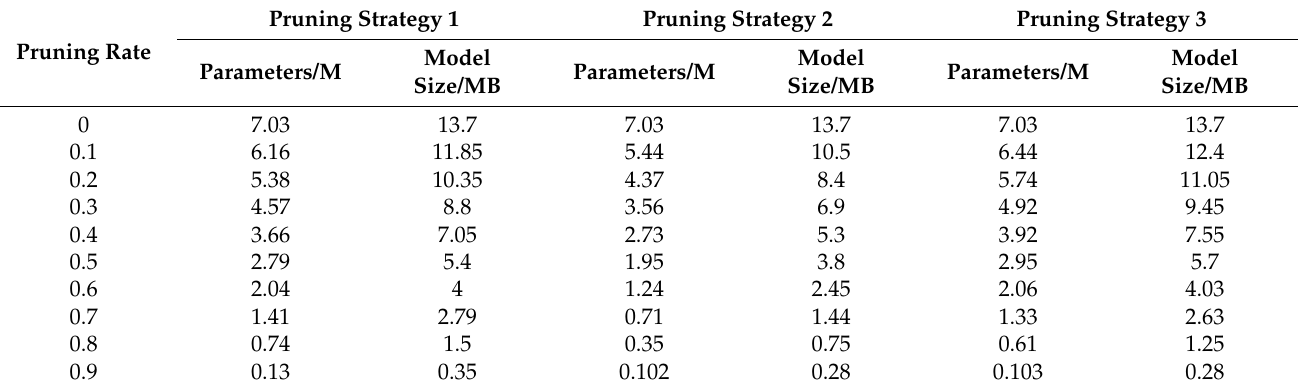
Table 3. The effect of different pruning strategies and different pruning rates on network